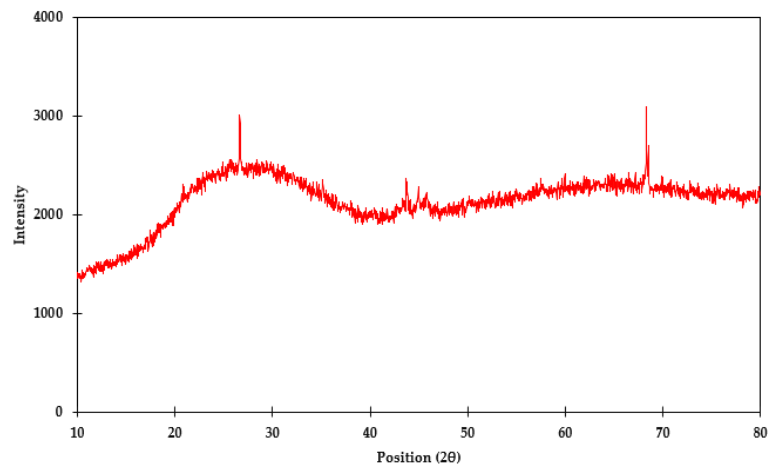
Figure 3. XRD pattern of vitrified As in glass material